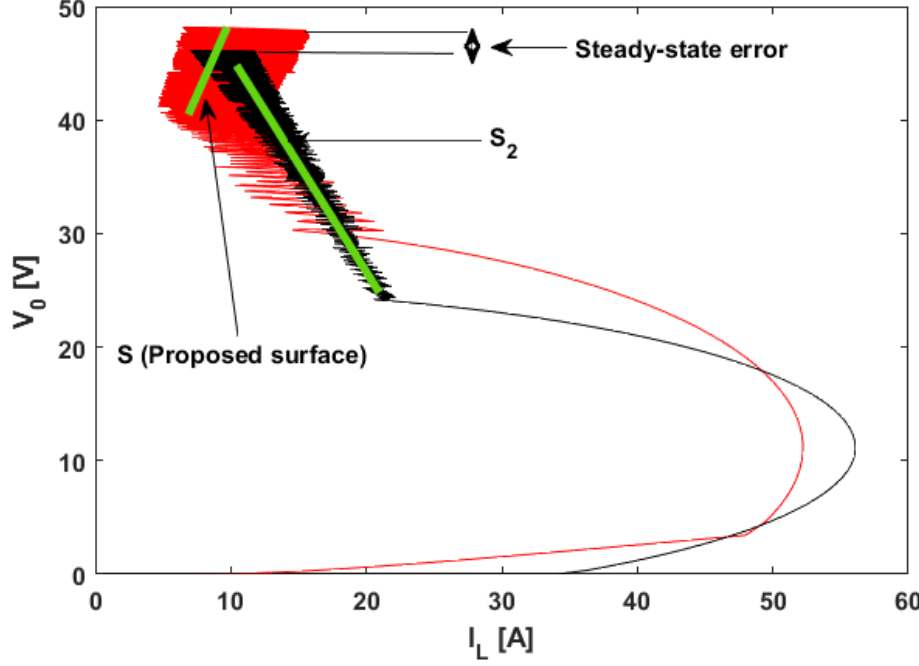
Figure 9. The motion of state variables on the proposed surface and S 2